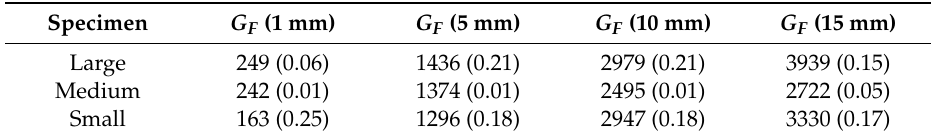
Table 4. Fracture energy values (N / m) for di ff erent deflection values and the coe ffi cient of